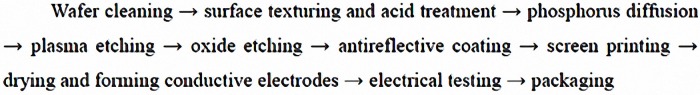
PV cell manufacturing process.